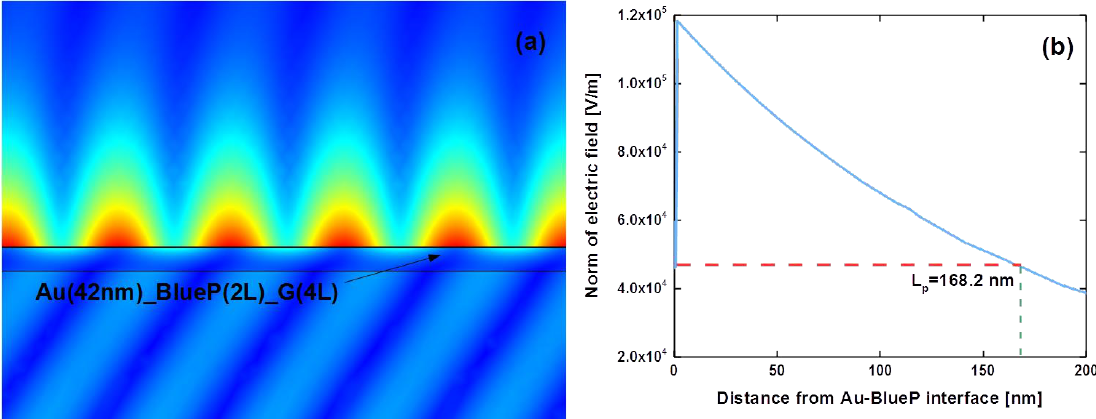
Figure 7. ( a ) The enhanced electric field distribution approaching the sensing interface based on the 42 nm Au film / 2-layer BlueP / 4-layer graphene. ( b ) Evanescent decay of significantly enhanced electric field penetrating into the sensing medium. The red line shows that the penetration depth (LP) is ∼ 168.2 nm, which can be obtained by calculating the distance from the point with the largest intensity to the point whose intensity reduces to 1 / e of the largest value. Annotation: Au (42 nm)_BlueP (2L)_G(4L) in Figure 7a is the abbreviation of our proposed configuration (42 nm Au film / 2-layer BlueP / 4-layer graphene.